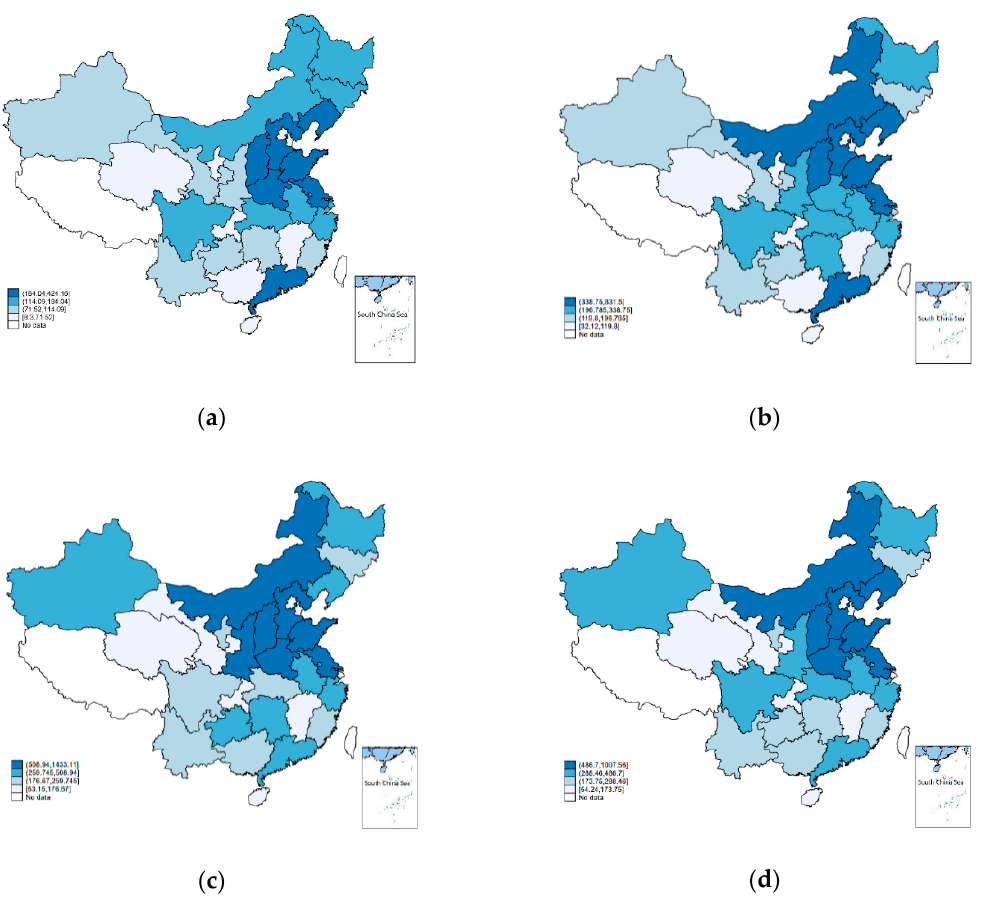
Figure 1. Variation trend of spatial distribution of carbon emissions of China in ( a ) 2003, ( b ) 2008, ( c ) 2012, and ( d ) 2016.